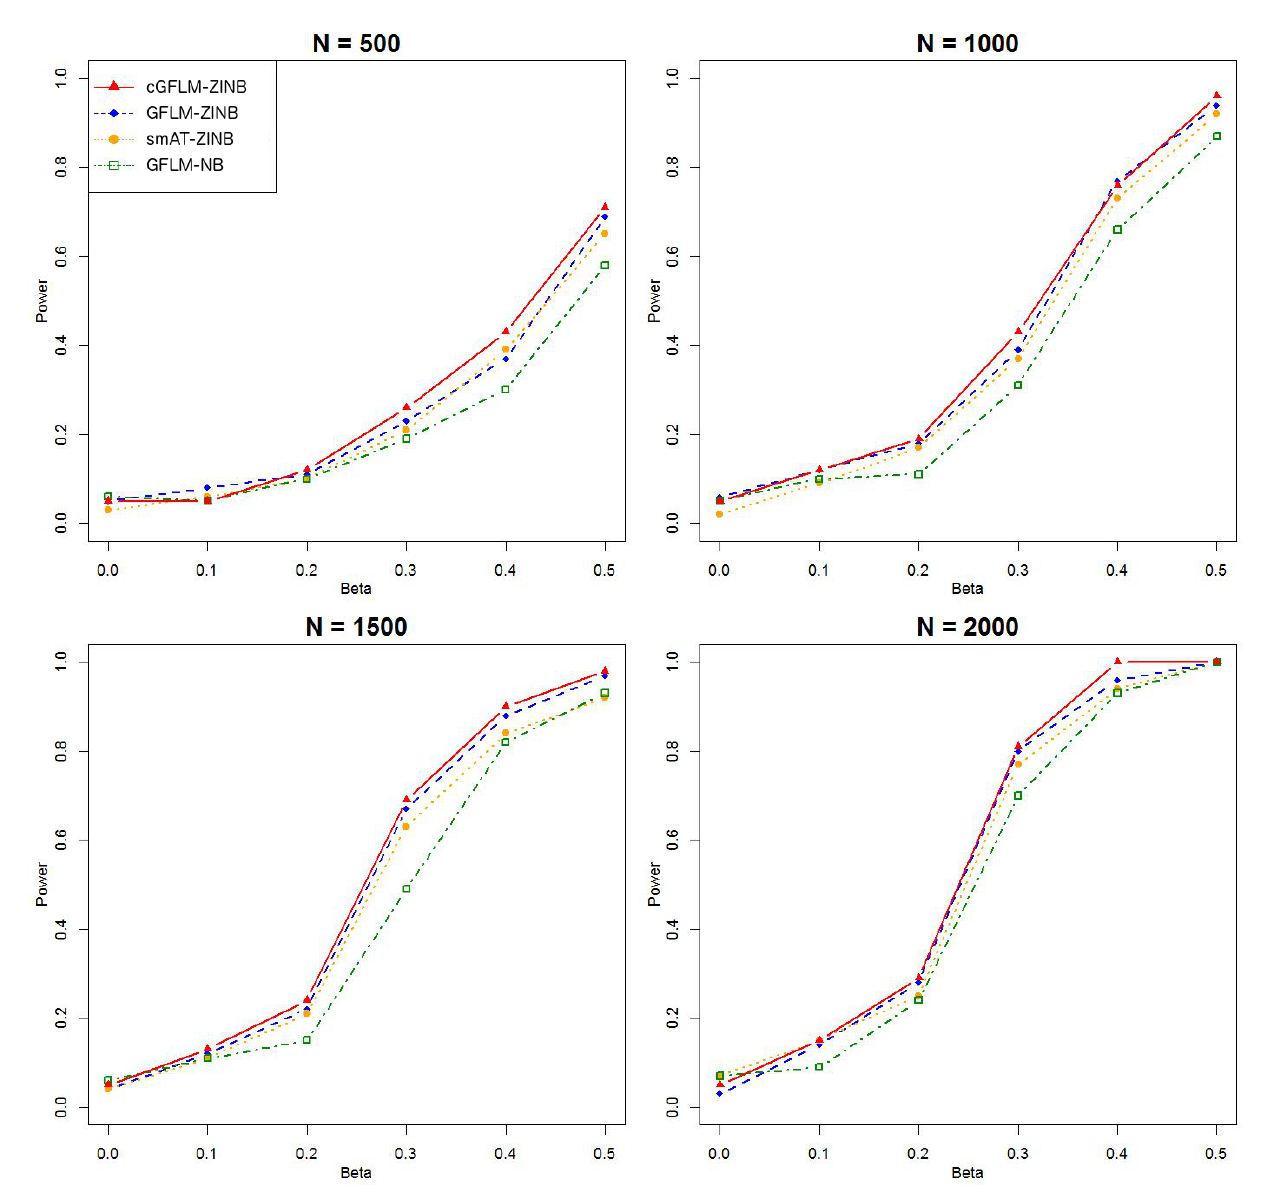
Figure A5. Power simulation for ZINB outcomes based on the CHRNA7 gene, single causal locus, effect in NB